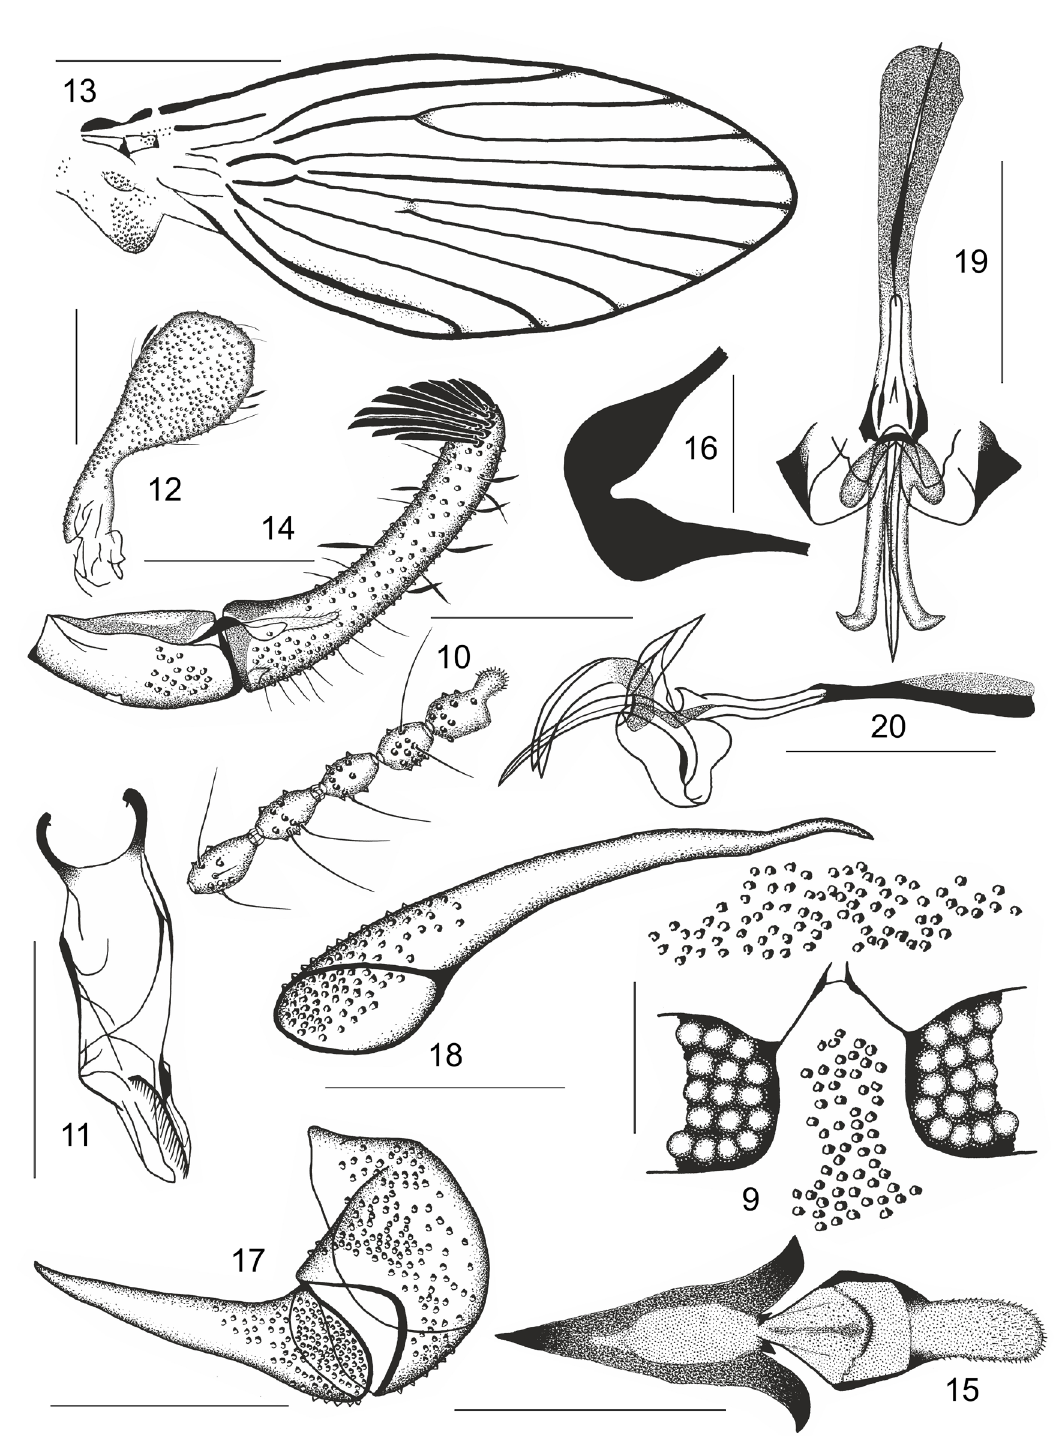
Figs 9–20. Pneumia fuehzulii sp. nov., ♂. 9 . Frons and facets in detail. 10 . Apical flagellomeres. 11 . Cibarium, labrum and epipharynx, dorsal view. 12 . Halter, lateral view. 13 . Wing. 14 . Epandrial appendages, lateral view. 15 . Ventral epandrial plate in detail, dorsal view, epiproct, hypoproct (variability). 16 . Hypandrium in detail, dorsal view. 17 . Gonopod, lateral view. 18 . Gonostylus, lateral view. 19 . Aedeagal complex incl. parameres, dorsal view. 20 . Same, lateral view. Scale bars: 9–10, 16 = 0.1 mm; 11–12, 14–15, 17–20 = 0.2 mm; 13 = 1